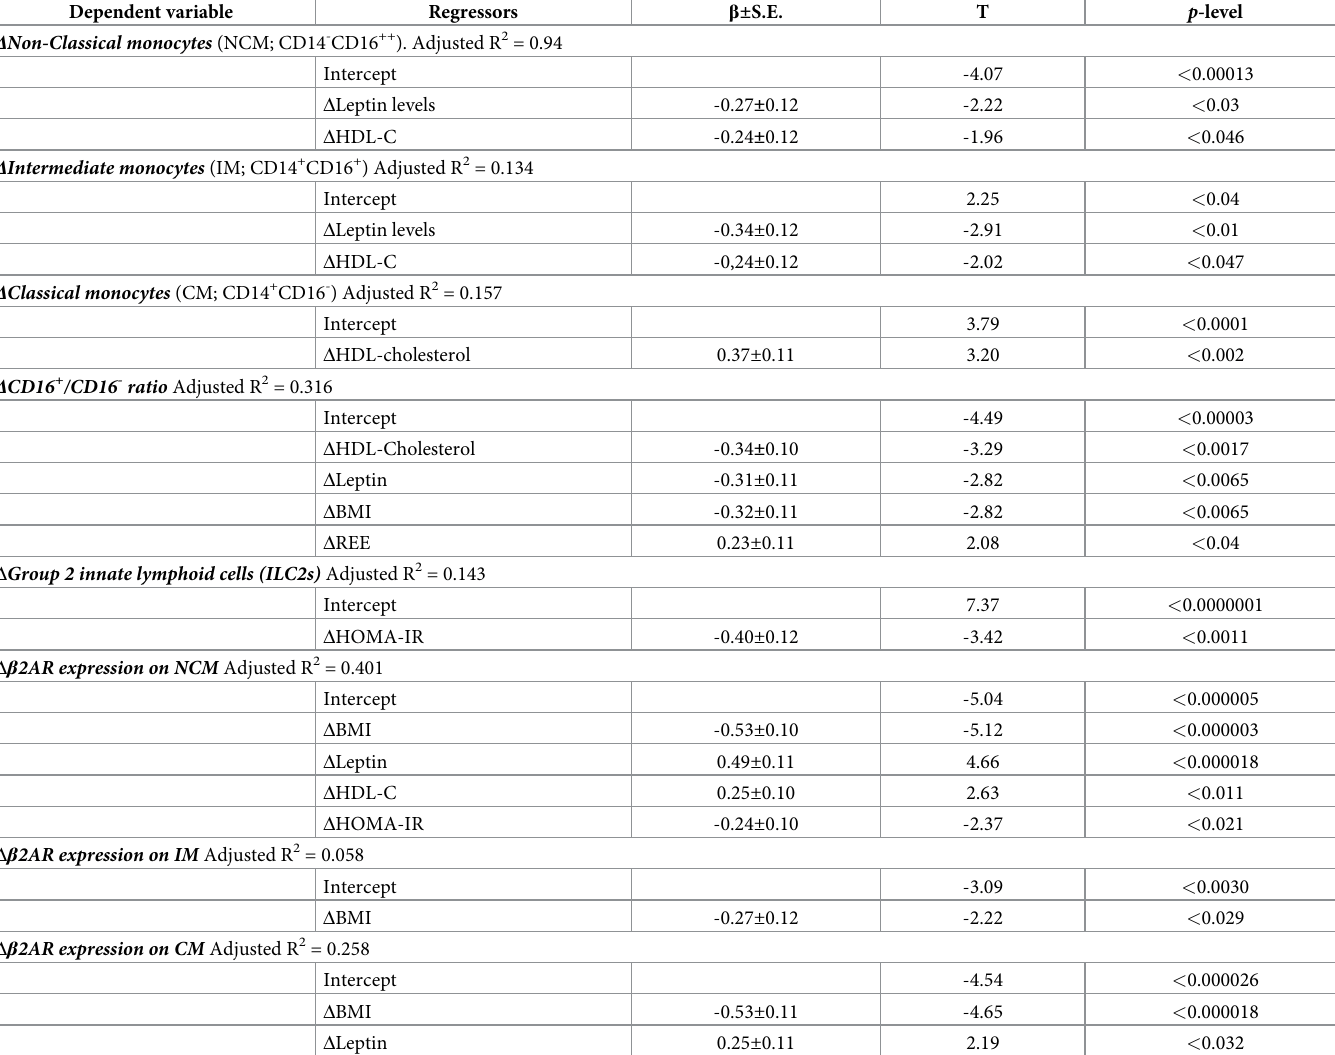
Table 4. Associations of changes in monocytes subsets, ILC2s, and β 2AR expression within Mo subsets with anthropometric and metabolic features after dietary restriction. Dependent